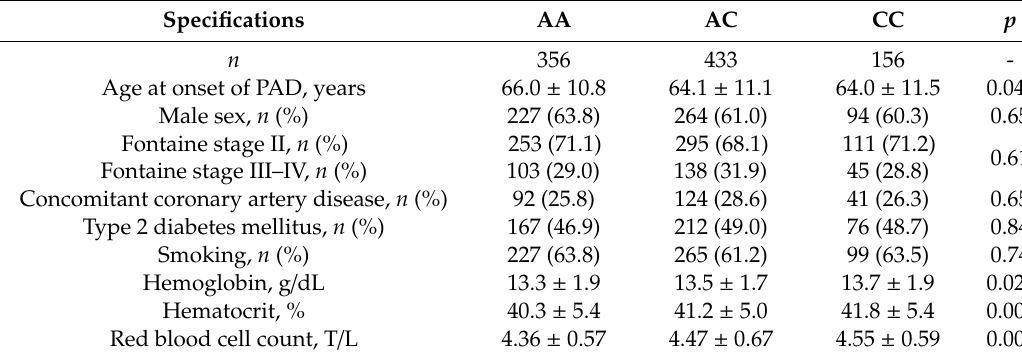
Table 2. EPO genotypes and peripheral arterial disease (PAD)